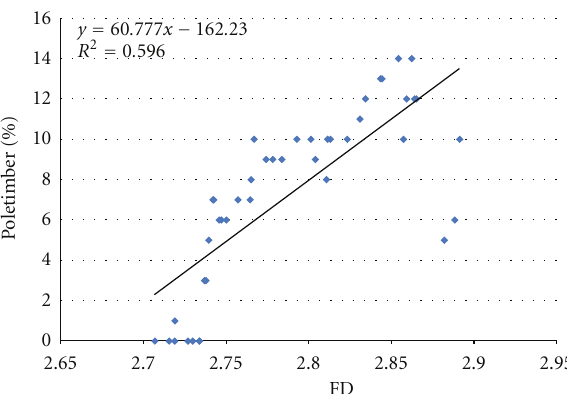
Figure 11: FD versus poletimber (bounds excluded).